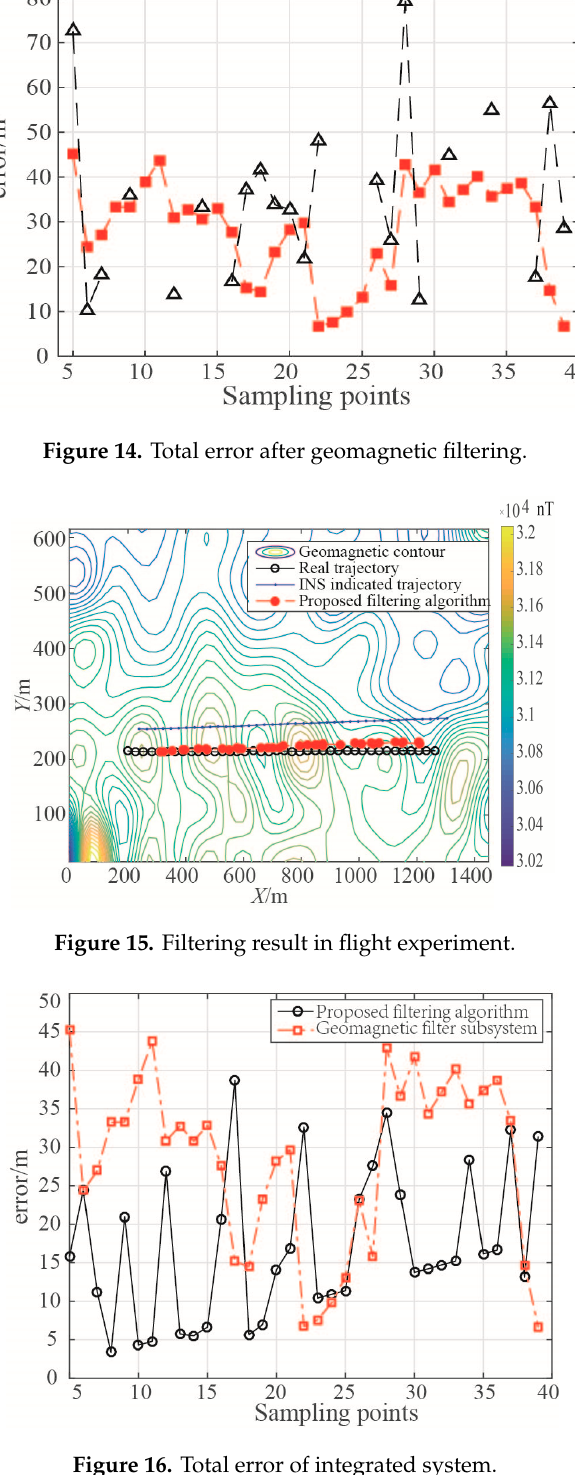
Figure 16. Total error of integrated system. Table 3. Results of flight experiment (Unit: m).